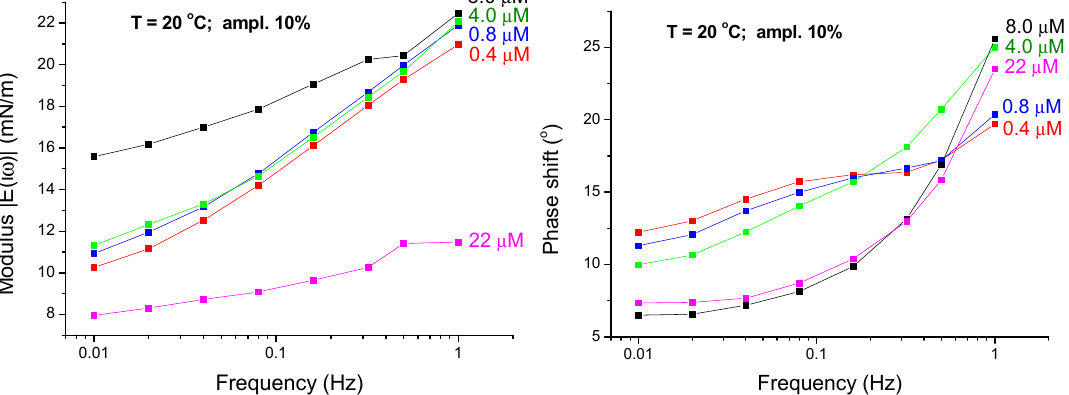
Figure 3. Viscoelasticity modulus | E ( i ω ) | and phase shift ϕ ( ω ) as functions of the frequency for C 13 DMPO concentrations of 4.0 × 10 − 7 , 8.0 × 10 − 7 , 4.0 × 10 − 6 , 8.0 × 10 − 6 and 2.2 × 10 − 5 mol/dm 3 (injections 2-1 to 6-1) at a fixed TTAB concentration of 4.5 × 10 − 5 mol/dm 3 (T = 20 °C; ampl. 10%); the lines are guides for the eye.